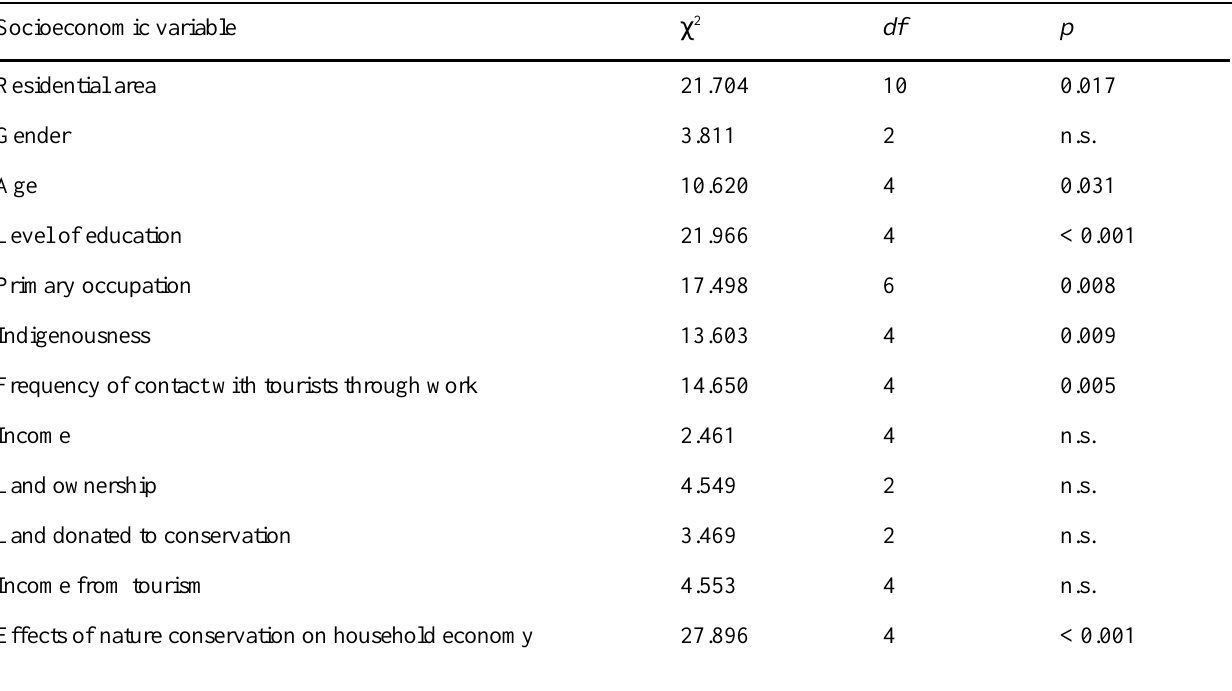
Table 4 . Dependency between the groups of respondents divided by clustering according to their opinions about nature conservation and tourism development (Chi-square analysis), n =